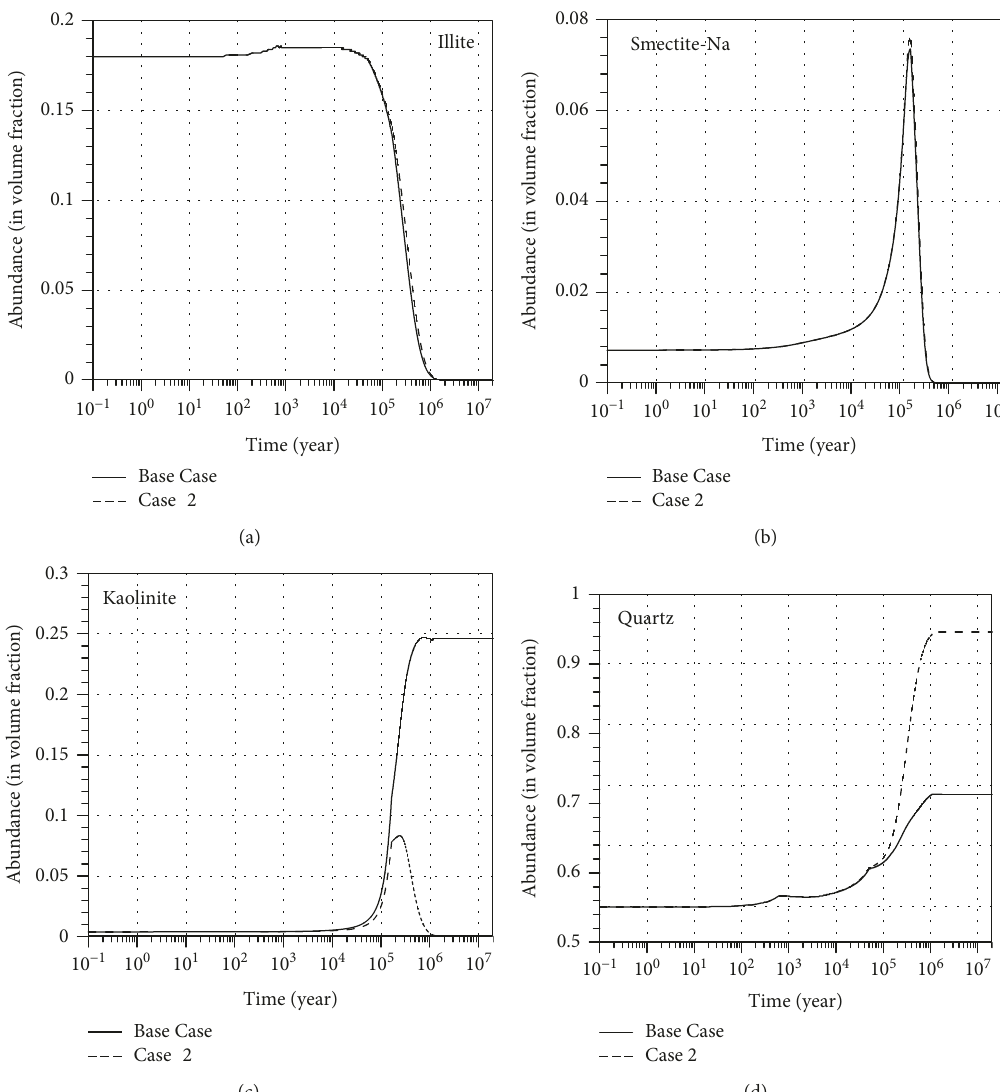
Figure 7: Variations in abundance (in volume fraction of rock grains) of illite (a), smectite-Na (b), kaolinite (c), and quartz (d) versus time obtained with (Case 2) and without (Base Case) considering the scour of